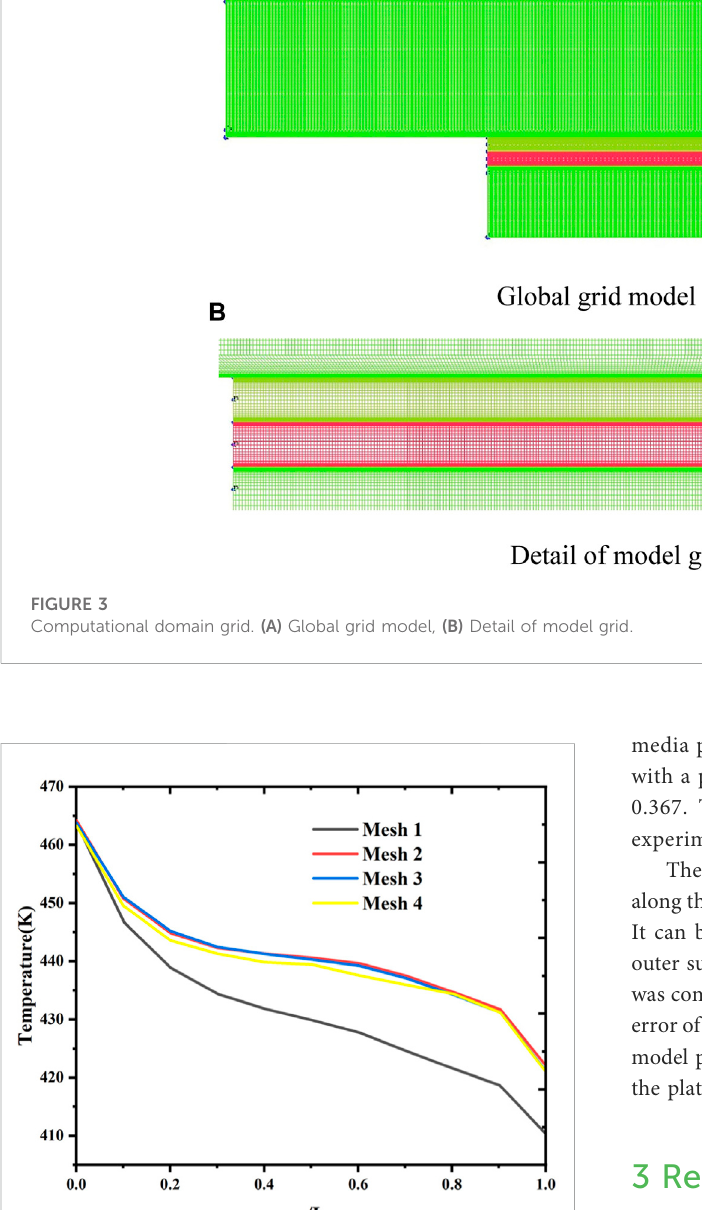
FIGURE 4 Mesh independence veri fi